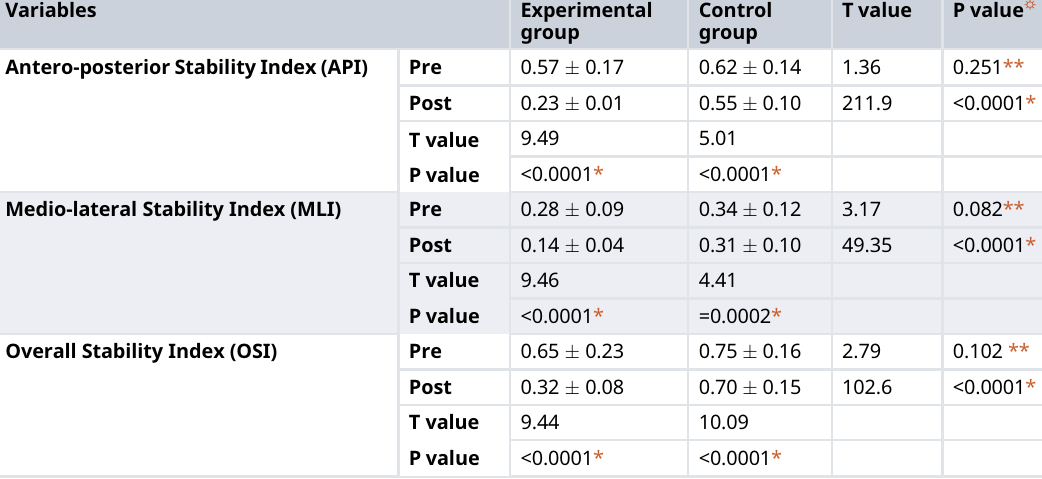
Table 3. Pre and post-treatment mean values of postural stability indices within each group and between groups.